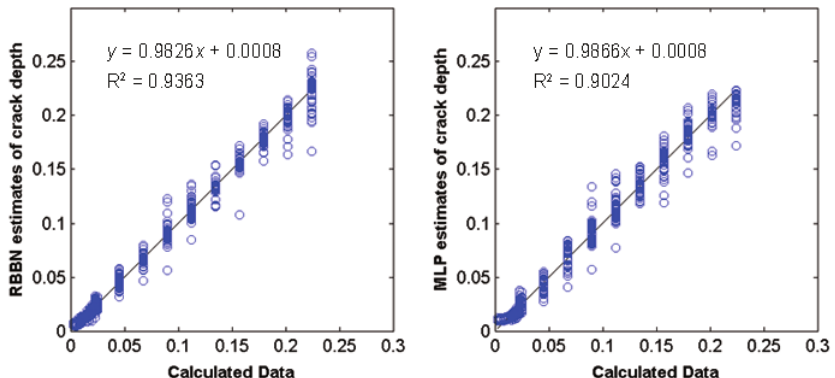
Fig. 7. Calculated and modelled crack severity by RBNN and MLP models in test